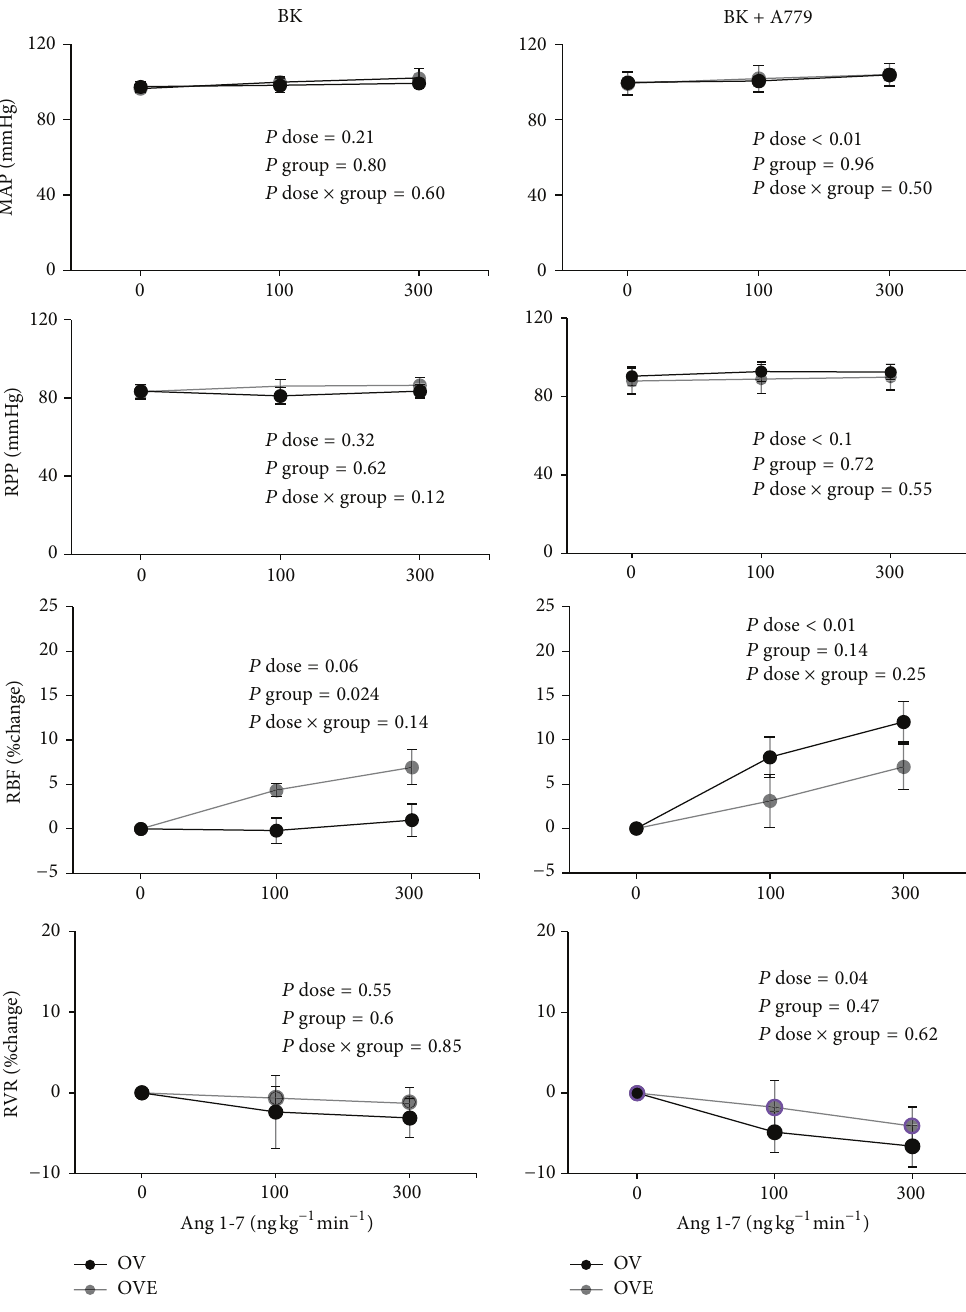
Figure 3: RBF, MAP, RPP, and RVR responses to Ang 1-7 were present when BK or A779 + BK was administrated. Data are shown as mean ± SEM. MAP, mean arterial pressure; RPP, renal perfusion pressure; RVR, renal vascular resistance; RBF, renal blood flow. P values were derived from repeated measures